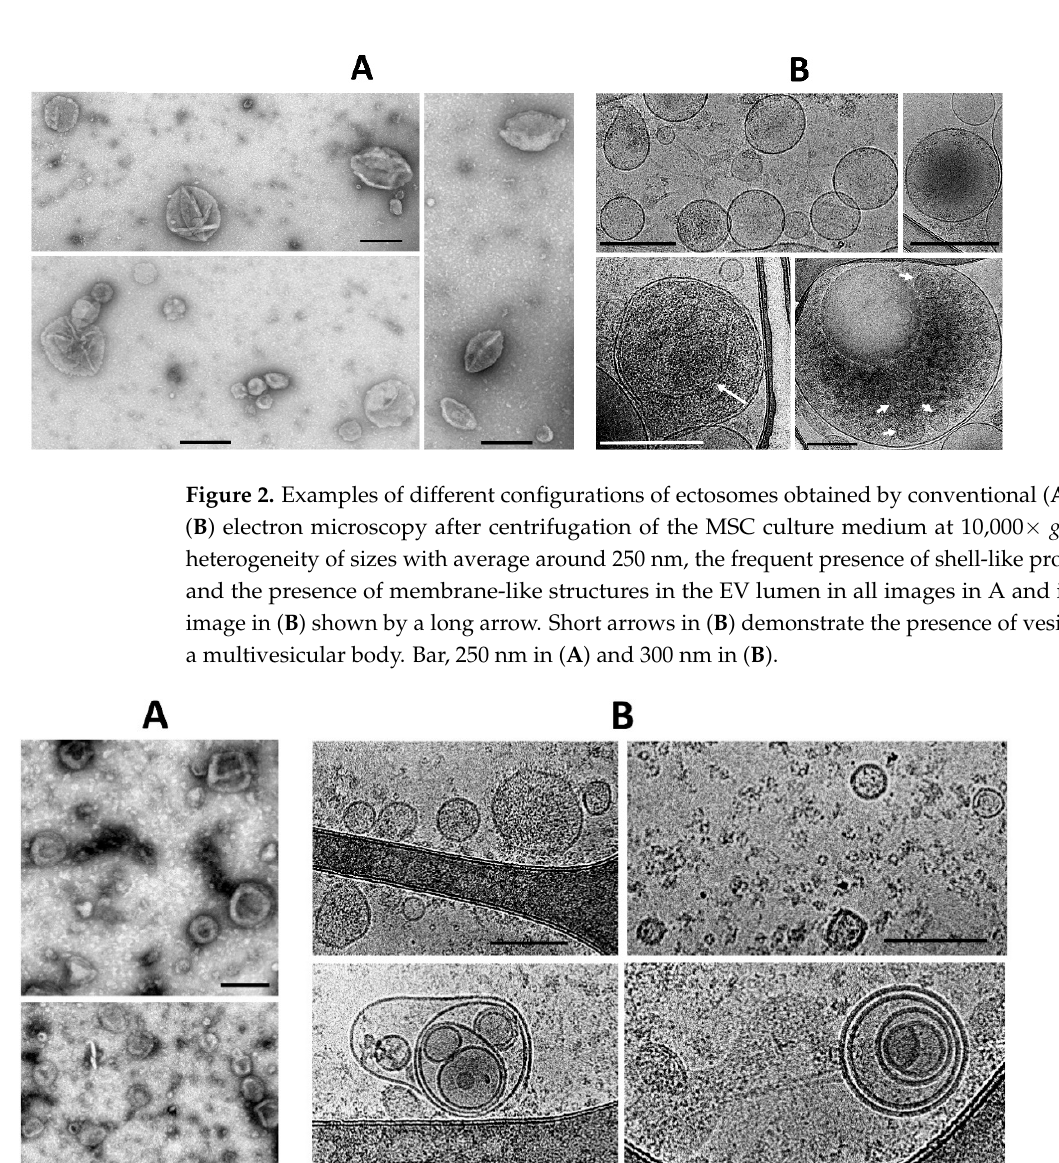
Figure 2. Examples of different configurations of ectosomes obtained by conventional ( A ) and cryo ( B ) electron microscopy after centrifugation of the MSC culture medium at 10,000× g . Note the het ‐ erogeneity of sizes with average around 250 nm, the frequent presence of shell ‐ like profiles in ( A ), and the presence of membrane ‐ like structures in the EV lumen in all images in A and in a simple image in ( B ) shown by a long arrow. Short arrows in ( B ) demonstrate the presence of vesicles within a multivesicular body. Bar, 250 nm in ( A ) and 300 nm in ( B ).